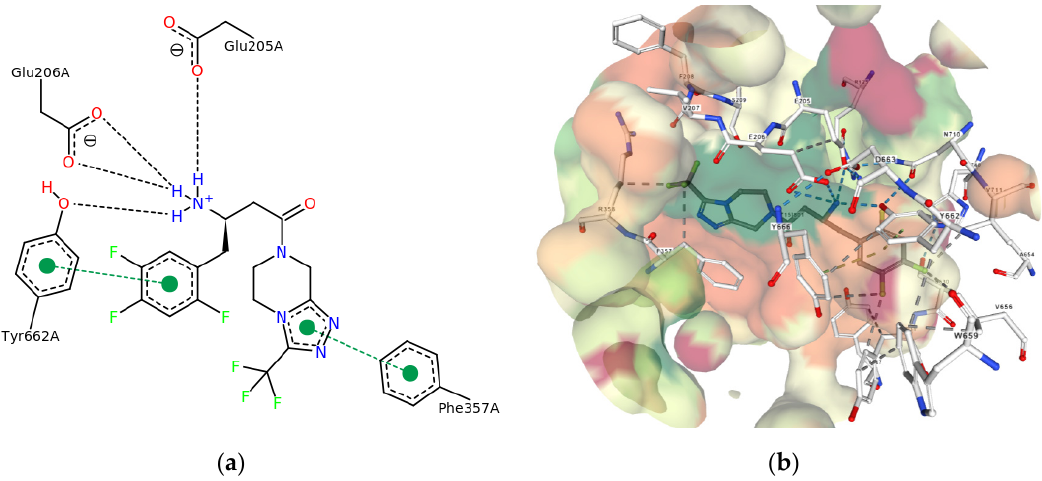
Figure 3. The binding mode of sitagliptin with DPP-IV: 2D ( a ) and 3D ( b ) (Downloaded from https://www.rcsb.org/3d-view/1X70).